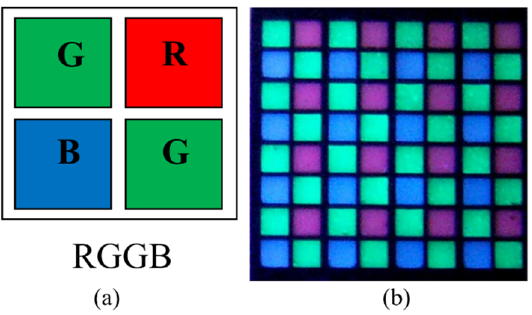
Figure 9. ( a ) Single color pixel composition; ( b ) Full-color display using UV LED to excite the RGB phosphor. Reproduced from [55], with permission from John Wiley and Sons, 2012.